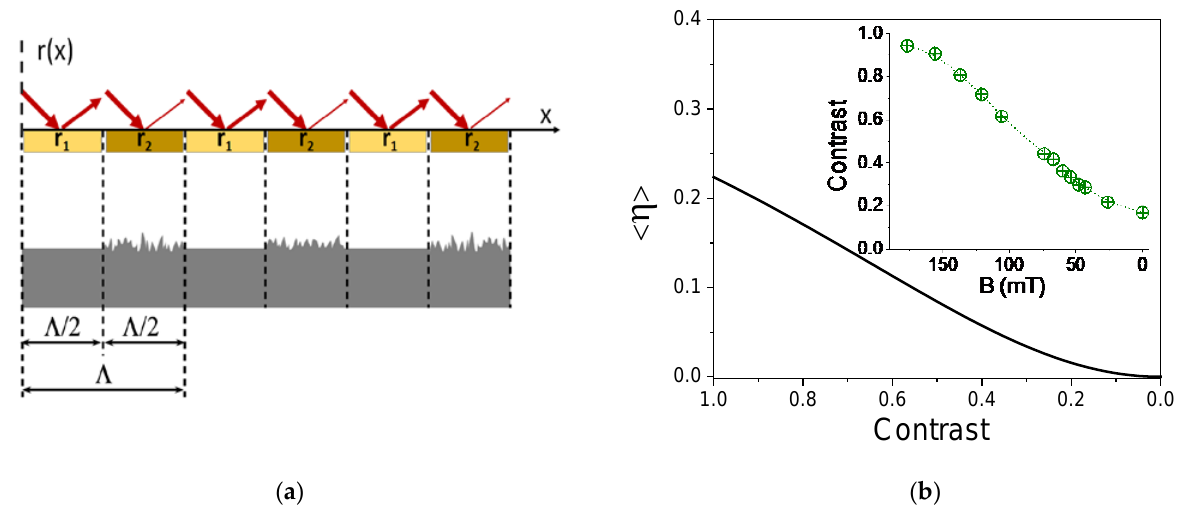
Figure 7. ( a ) Schematic drawing of the optical grating composed of parallel reflective stripes with amplitude reflectivity coefficients r 1 and r 2 < r 1 (top drawing) and the corresponding MAE surface topography (bottom drawing). ( b ) Calculated dependence of diffraction efficiency < η > of the ± 1st diffraction orders as a function of reflectivity contrast c = ( r 1 − r 2 )/( r 1 + r 2 ). The inset gives the contrast of the grating lines for sample M2 as a function of magnetic field B calculated on the basis of the experimental data shown in Figure 5a.